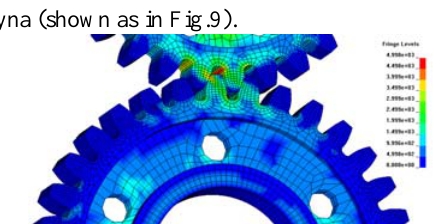
Fig.9. The analysis model of the first gear